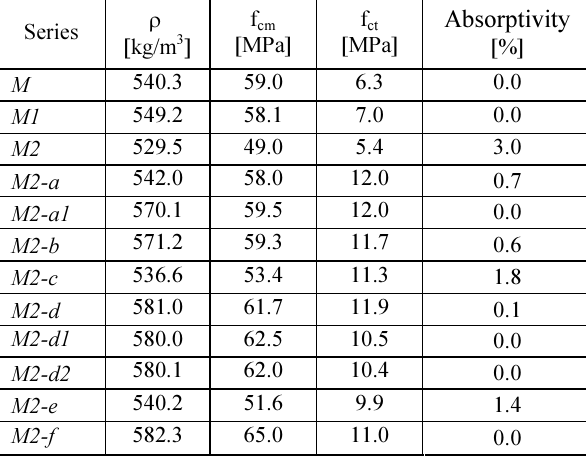
Table 4. Research results of hardened self-compacting